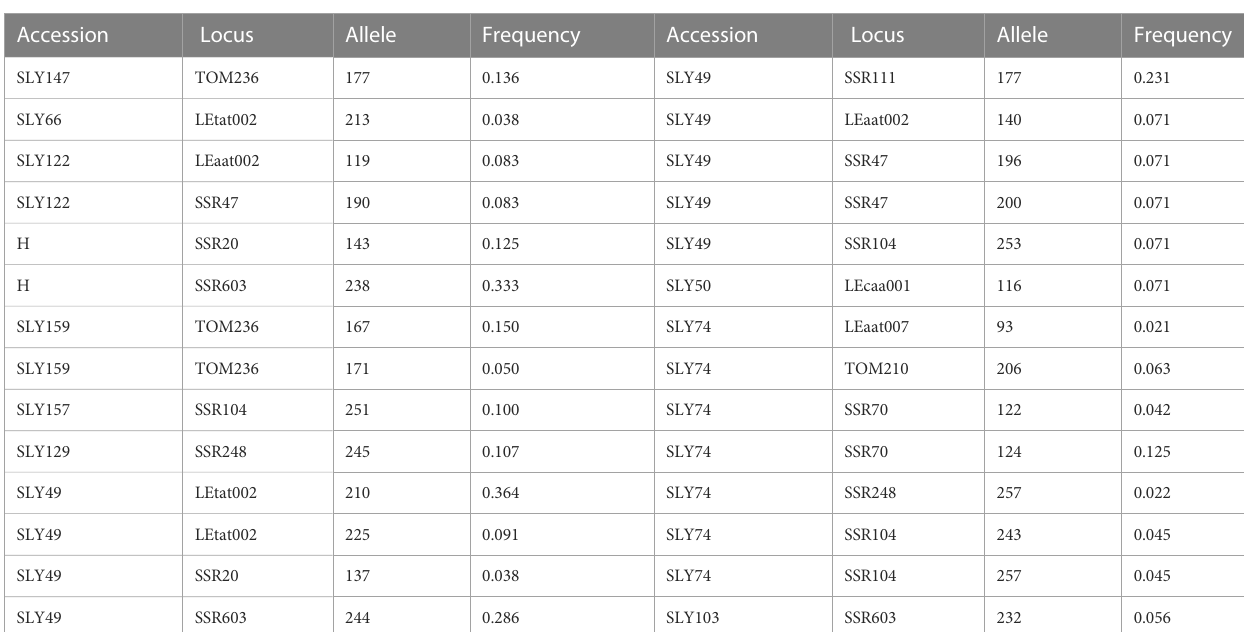
corresponds to the genotypic dendrogram cluster II.a.6, composed larger terminal lea fl et (SLY47, SLY70, and SLY66) (Figure 2D), and the Structure classi fi cation related to A and B; associated with this cluster in terms of phenotypic leaf morphology and Structure classi fi cation is SLY65; (ii) the phenotypic cluster I.b.1 that groups the landraces SLY39, SLY50, and SLY30, having complete correspondence with the genotypic node (II.a.6) and classi fi ed by structure as an admixture for K = 4; and (iii) the phenotypic cluster III characterized by pink tomatoes that can weigh over 500 g, corresponding to cluster II.a.7 from the genotypic dendrogram, which was classi fi ed as light blue (A) by Structure ( K = 4).